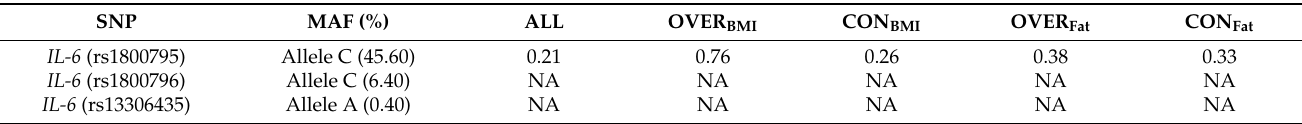
Table 2. Frequencies for IL-6 genotypes in ALL, OVER BMI , CON BMI , OVER Fat and CON Fat groups; probabilities that the genotype frequencies do not differ from Hardy–Weinberg expectations (HWE) and minor allele frequency (MAF). SNP